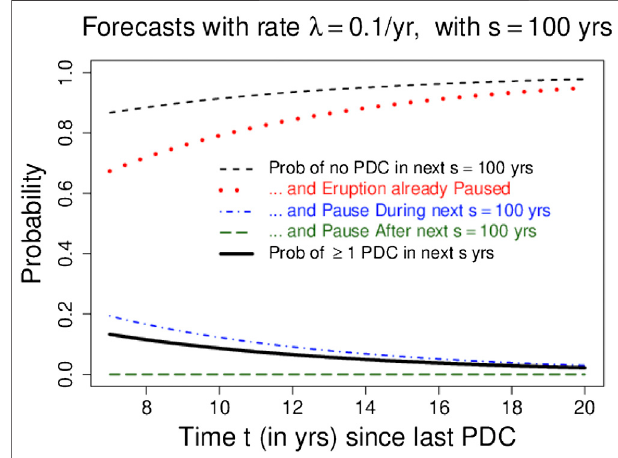
FIGURE 5 | Solid black curve shows forecast probability of at least one PDC in s (cid:2) 100 years, assuming an activity rate of λ (cid:2) 0 . 1 event per year, starting t years after the most recent eruption for 7 ≤ t ≤ 20. Dotted red curve shows forecast probability that the eruption has already ended by time t , rising from 67% at t (cid:2) 7 years (i.e., in 2020) up to 95% at t (cid:2) 20 years.